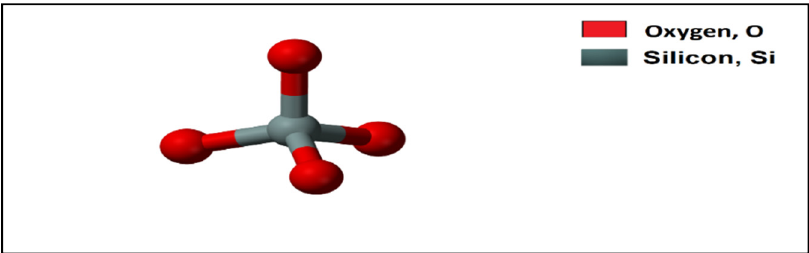
Figure 7. Chemical structure of silicate.